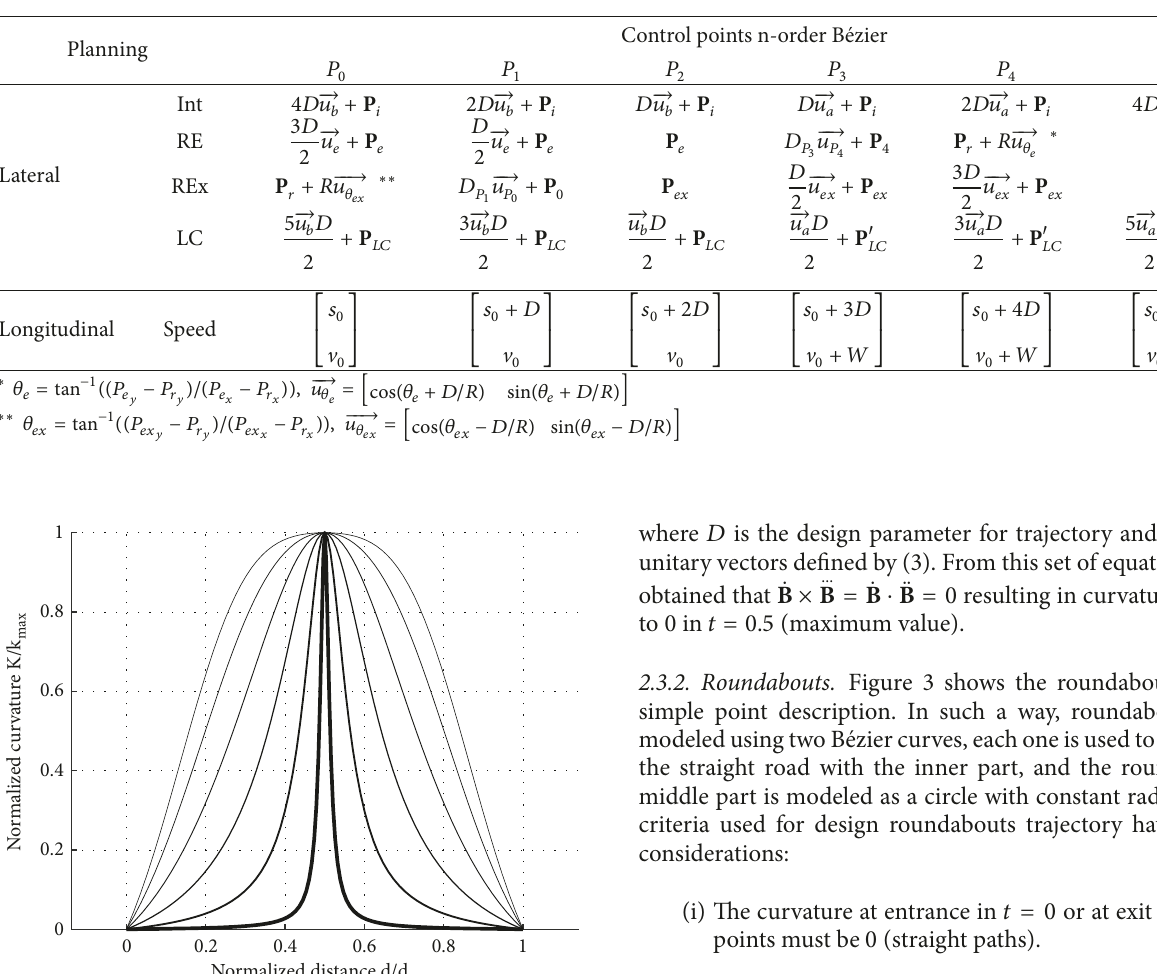
Table 2: B´ezier control points for lateral and longitudinal approach for intersections “Int”, roundabout entrance “RE”, roundabout exit “Rex”, lane change maneuver “LC”, and speed planning.